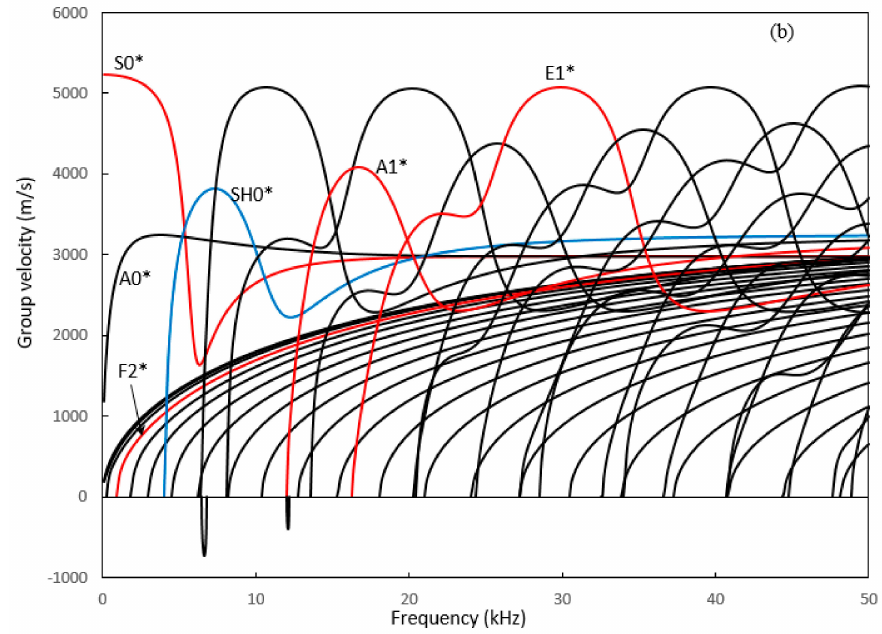
Figure 2. Dispersion curves for a steel plate with an aspect ratio of 40: ( a ) phase velocity; ( b ) group velocity.